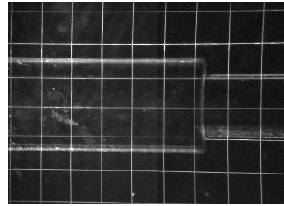
Figure 4. Calibration tool.